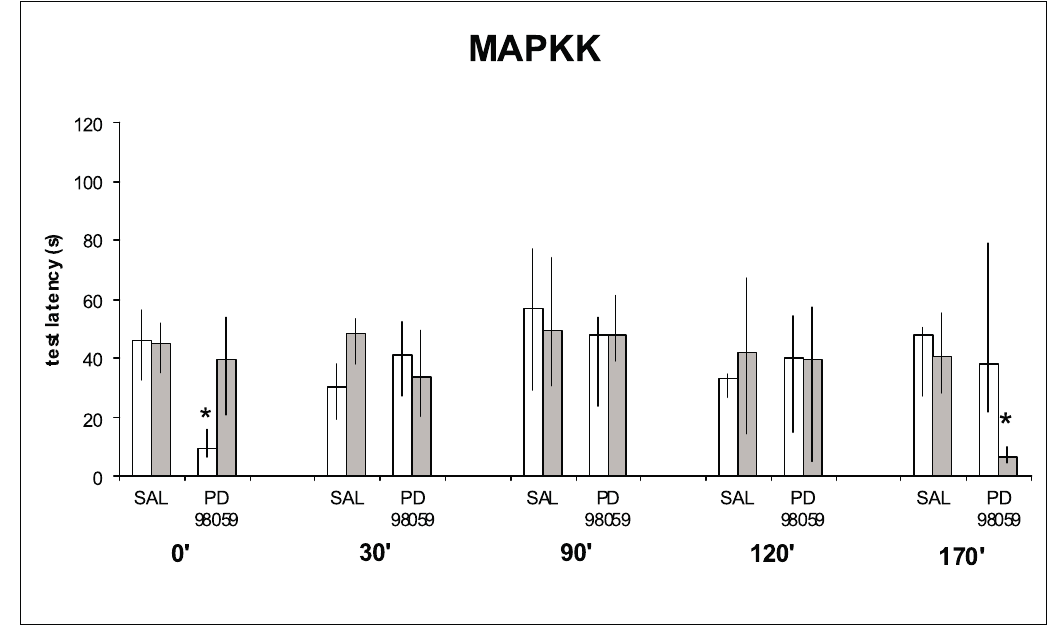
Fig. 4 – Same procedures as in other figures. Data from this figure is published else-where (Walz et al. 1999). Rats received bilateral infusions in the dorsal CA1 region of saline or of the selective inhibitor of MAPKK, PD 98059 (50 µ M). The infusions were given 0, 30, 90, 120 or 170 min after training. STM testing was at 180 min after training. ∗ Indicates significant difference from control values at p < 0 . 001 level. In groups not marked by asterisks the training-test latency differences were significant at a p < 0 . 001 level. PD 98059 given immediately after training selectively inhibited STM without affecting LTM. When given 170 min after training PD 98059 caused amnesia for